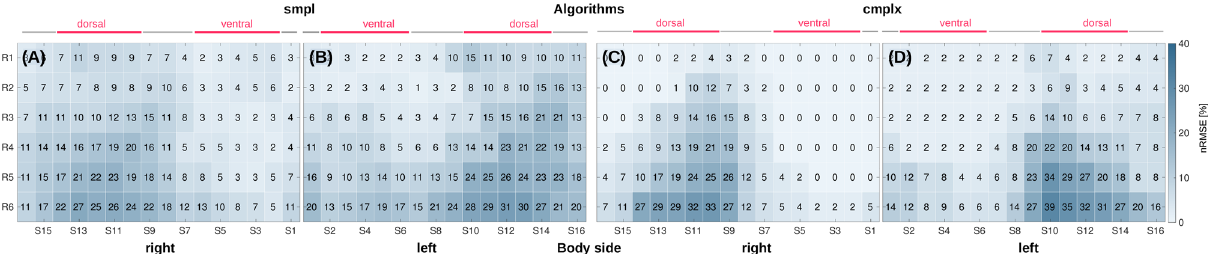
Figure 6. Algorithm comparison for stride duration estimation based on nRMSE maps averaged over all running athletes (running speed 5 m/s, right and left upper leg). ( A , B ) smpl algorithm. ( C , D ) cmplx algorithm.